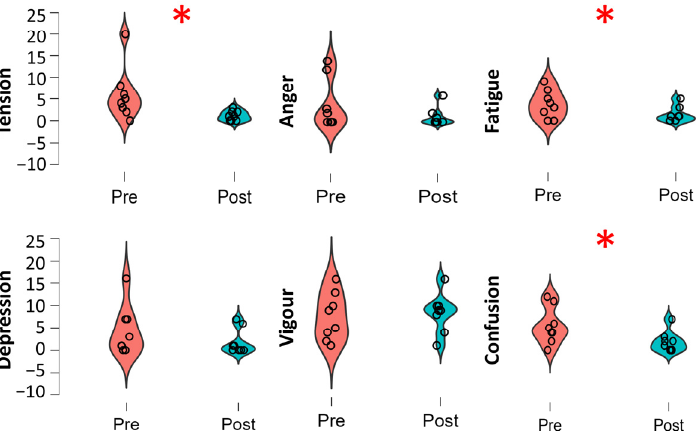
Figure 4. A comparison of the POMS subscales pre and post of the designed virtual game. * p < 0.05. Table 3. Statistical results for changes in POMS scores pre and post playing the virtual forest game. POMS Subscale